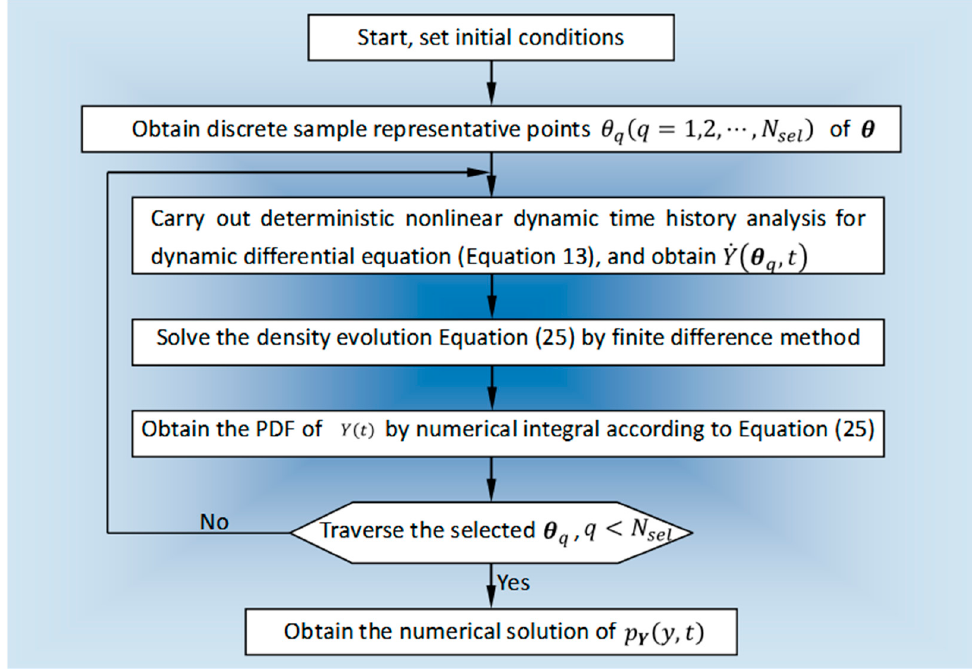
Figure 3. Numerical solution flow of PDF for the vibration-acceleration response of superstruc- ture.